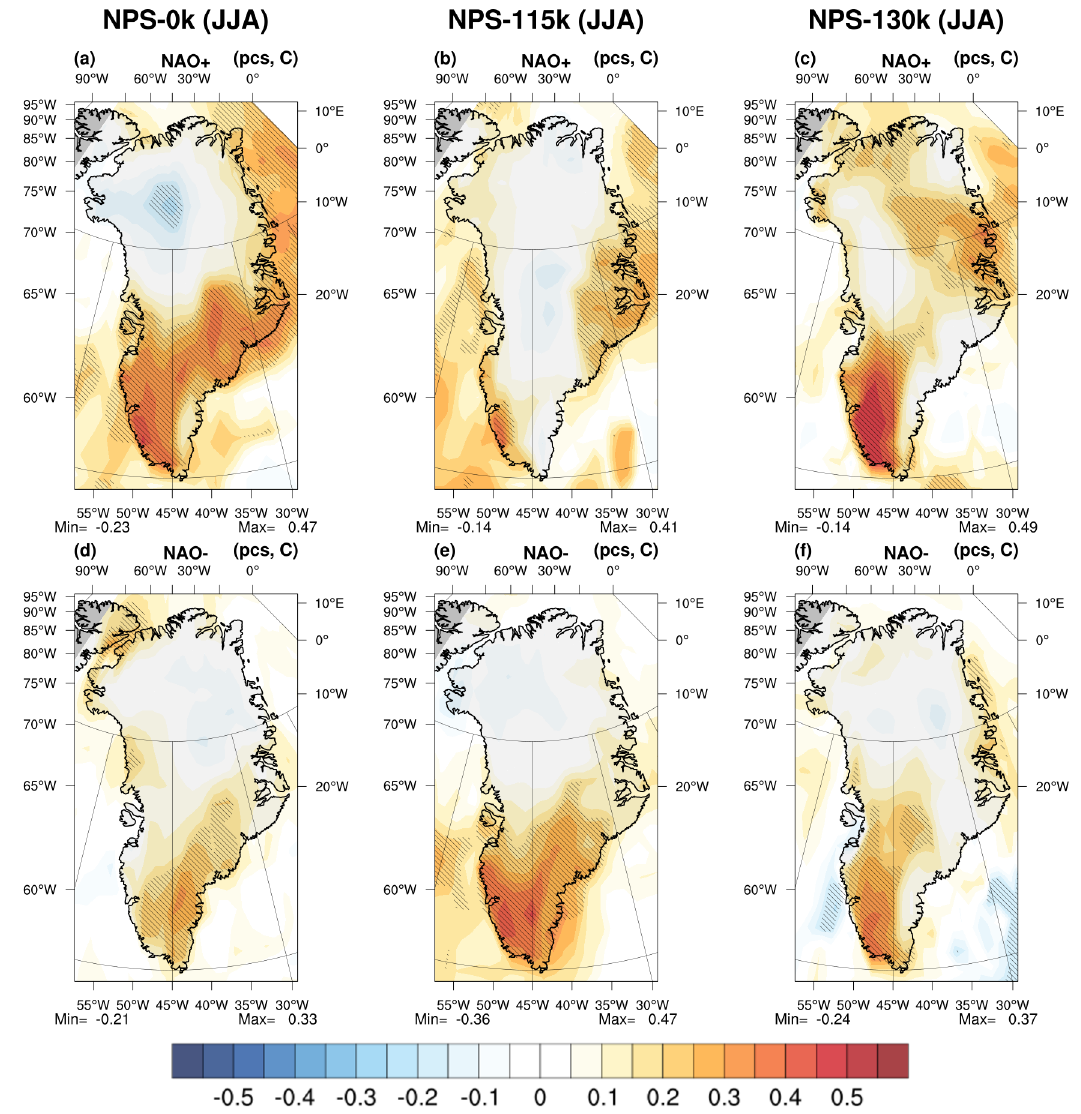
Figure 12. Same as Fig. 11, but for summer.